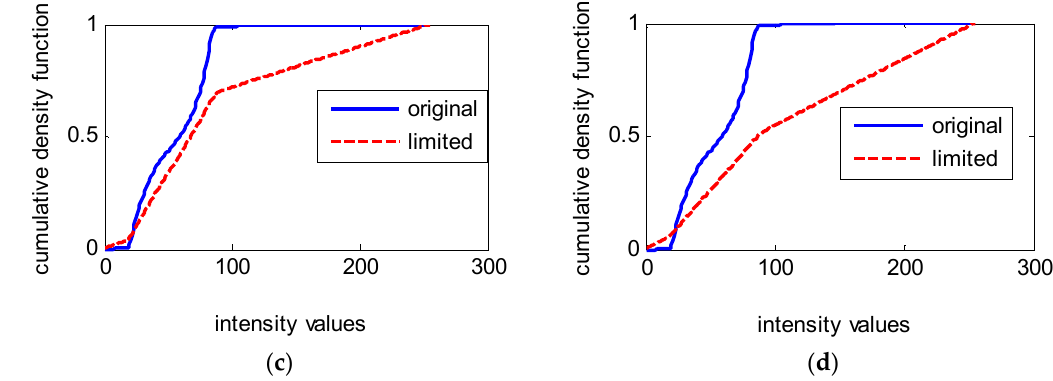
Figure 4. Clipping and redistribution of clipped histogram equalization. ( a ) Histogram of the original input image; ( b ) Histogram of the original input image and the modified histogram after redistribution; ( c ) The cumulative density function of original and modified histograms with β = 2.5 N av ; ( d ) The cumulative density function of original and modified histograms with β = 1.5 N av .